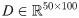
Comparison of K-SVD and R-SVD errors when k-Limaps (top) or SL0 (bottom) sparse decomposition methods are used.The surface represents the gap between final (T = 200) ESNR of K-SVD and R-SVD obtained with all parameter combinations L = 2000, 4000, 6000, 8000, 10000 and SNR = 0, 10, 20, 30, 40, 50, 60, ∞ (no noise). Results are averages over 100 trials; points are interpolated with coloured piece-wise planar surface for sake of readability. Left: D∈R50×100 with sparsity k = 5. Right: D∈R100×200 with sparsity k = 10.